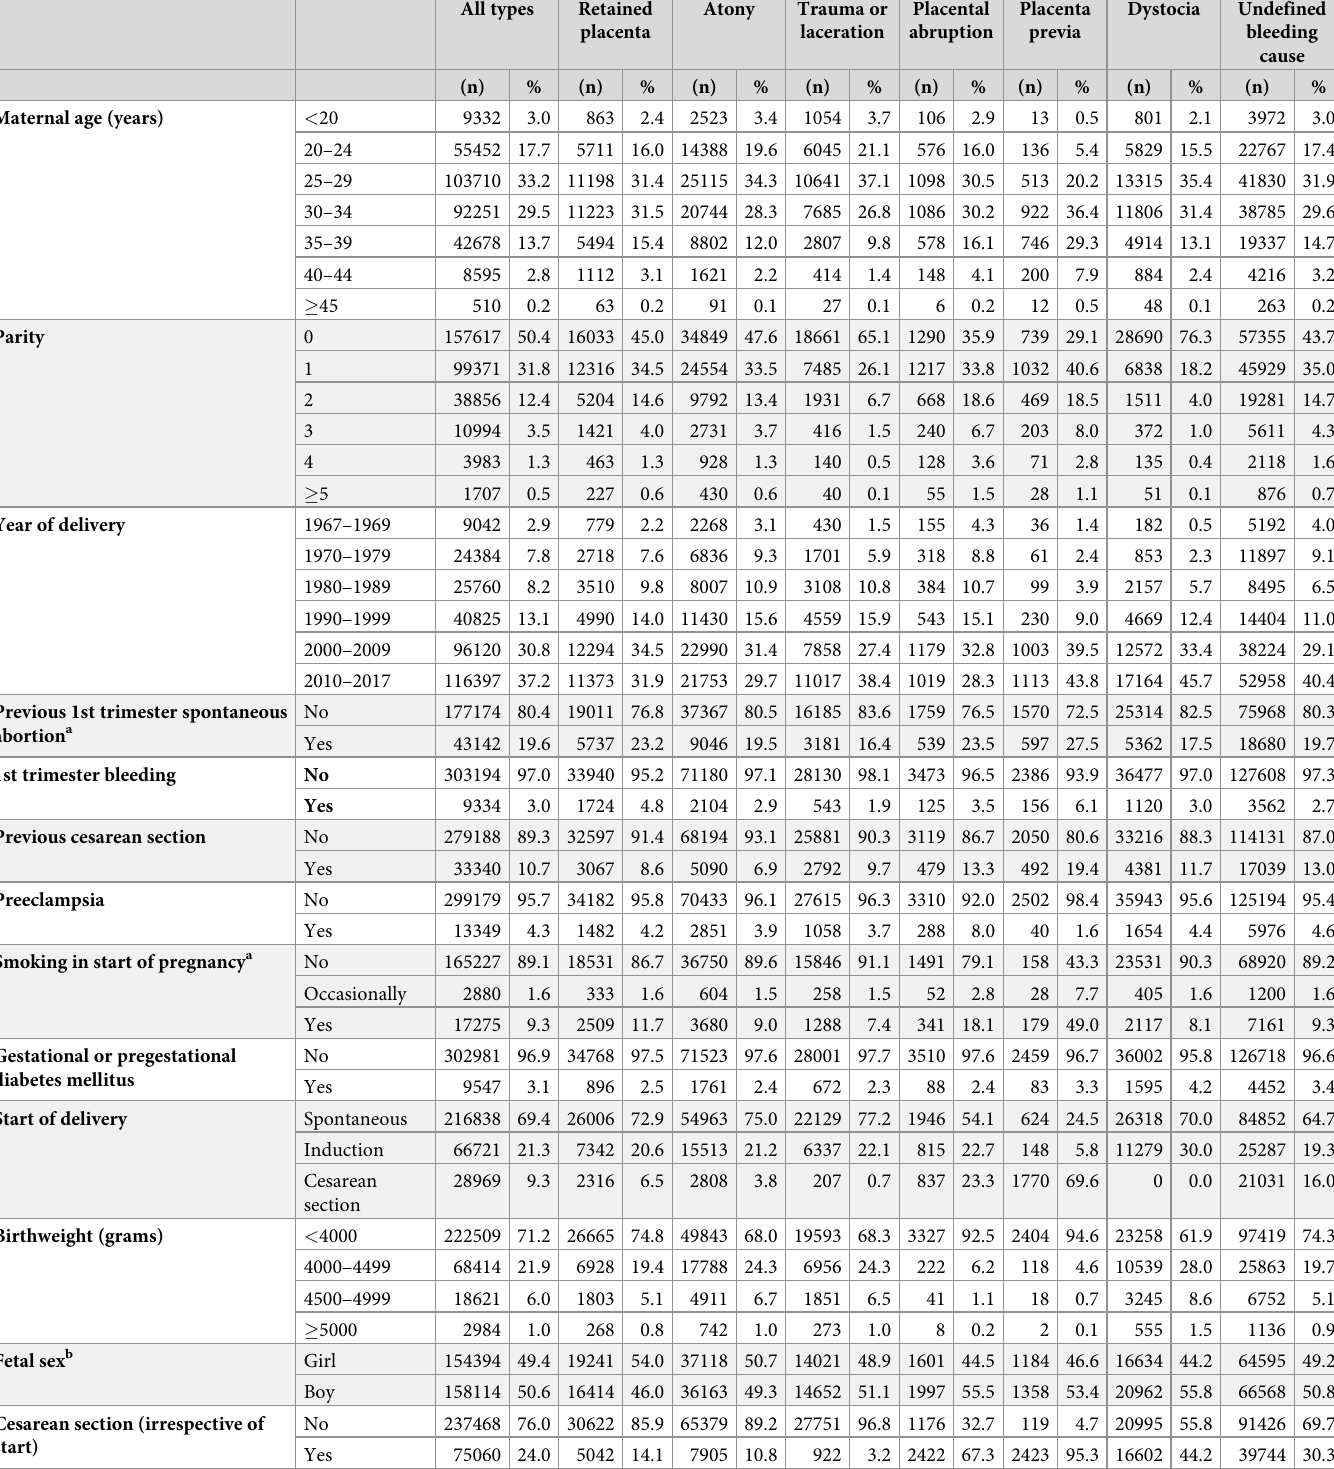
All types Retained Atony Trauma or Placental Placenta Dystocia Undefined placenta laceration abruption previa bleeding cause